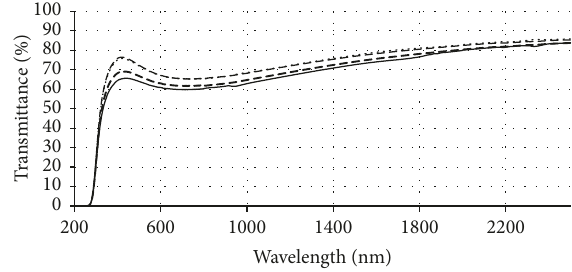
Figure 3: Effect of ultraviolet irradiation for one hour at 254